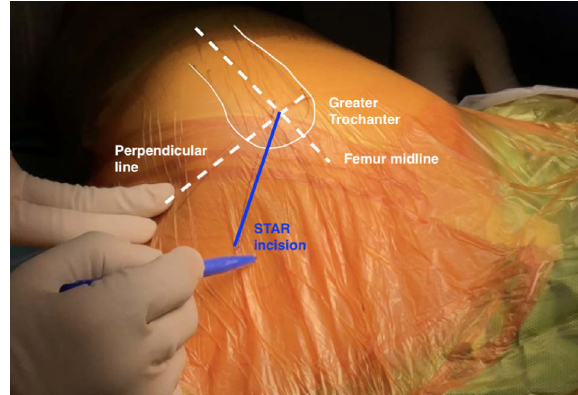
Figure 1. The STAR incision starts at the crossing of the femur ’ s midline with a perpendicular line two centimetres below the tip of the greater trochanter.